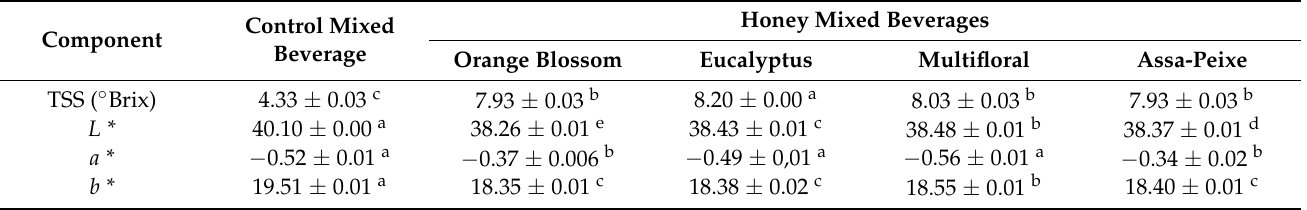
Results are expressed as mean ± standard deviations of three replicates. Different superscript letters in the same row indicate significant differences between mean values (one-way ANOVA followed by Tukey multiple comparisons posthoc test, p < 0.05). The CIELab color space was used to determine the coordinates L * (black (0) to white (100)), a * (green ( − ) to red (+)), and b * (blue ( − ) to yellow (+)).